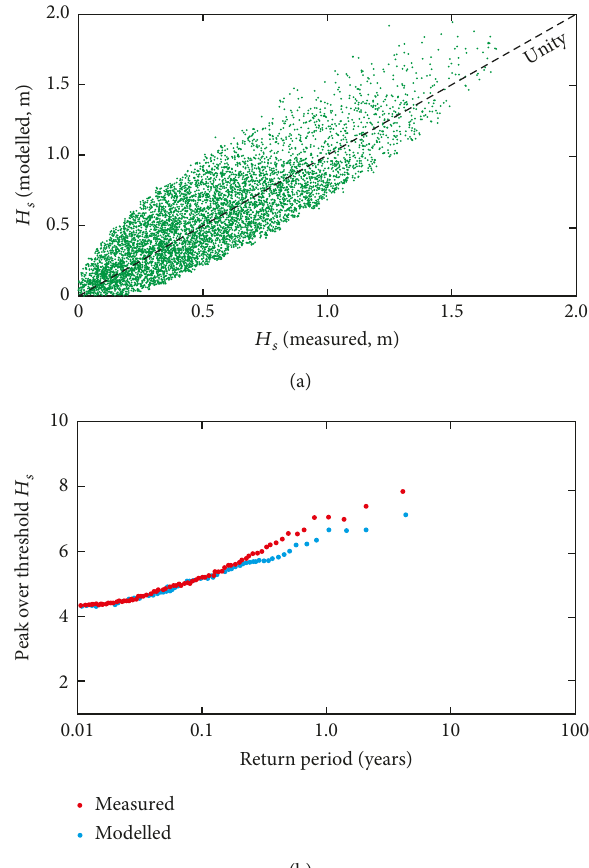
Figure 6: (a) Scatter diagram showing the relationship between measured and modelled H s and (b) a peak over threshold (POT) analysis of H s between modelled and measured wave